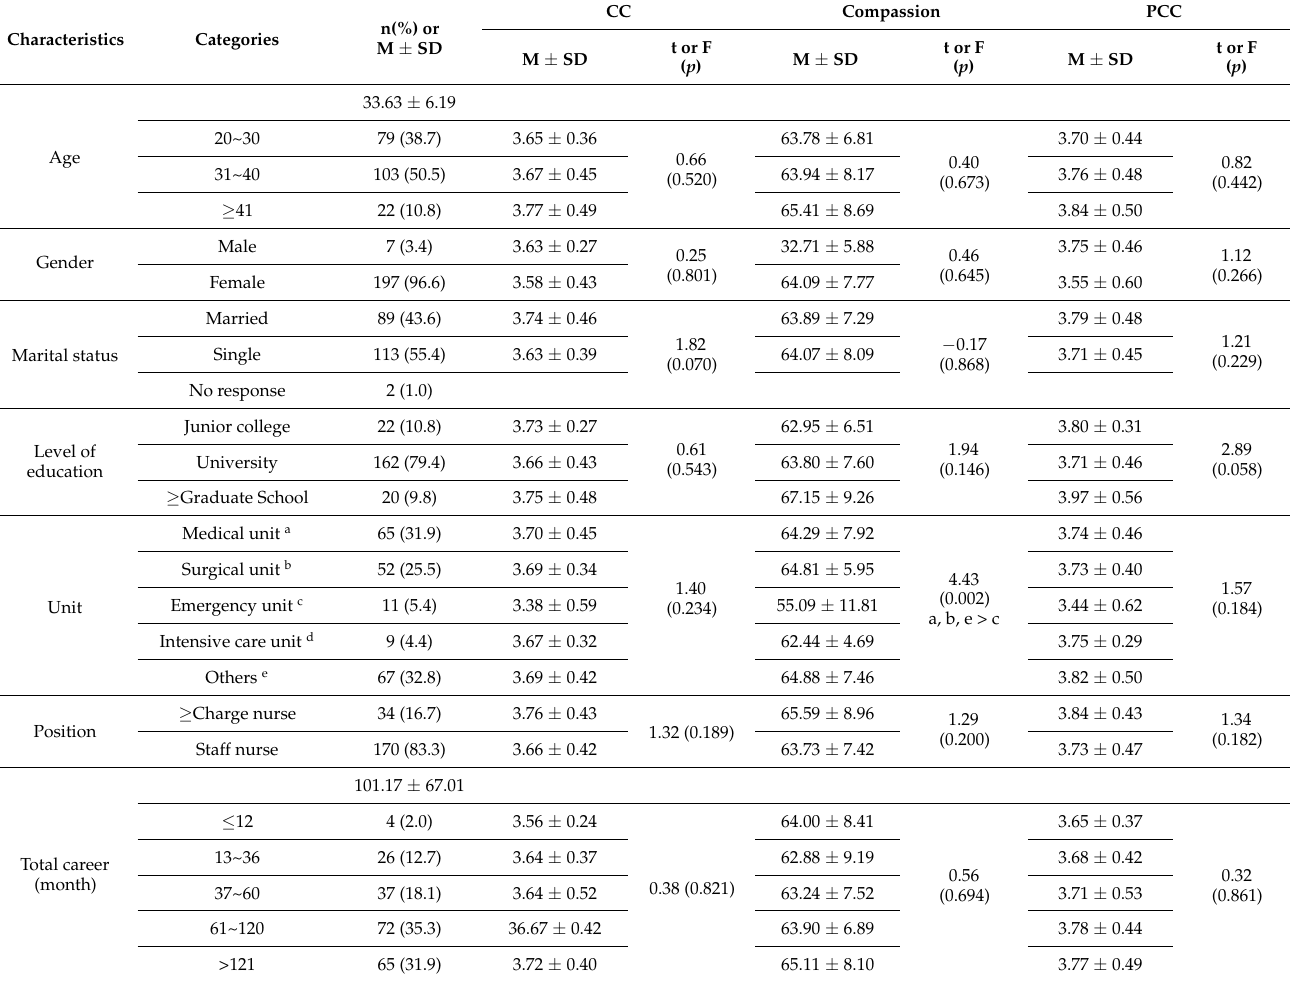
Table 1. Characteristics of the Participants ( N =